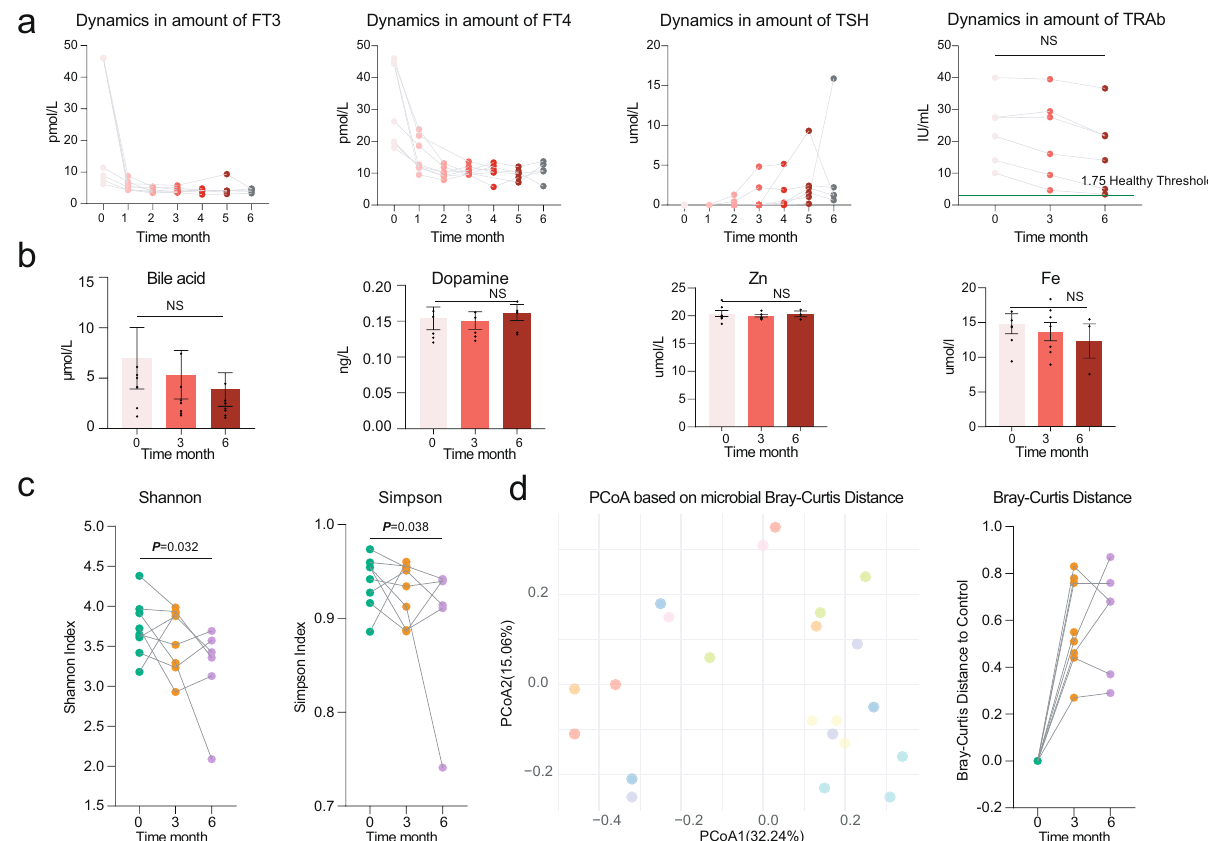
Fig. 2 The methimazole intake improved the thyroid function of GD patients. a Dynamic in the concentration of thyroid indexes including free triiodothyronine (FT3), free thyroxine (FT4), thyroid-stimulating hormone (TSH), and thyroid-stimulating hormone receptor antibodies (TRAb) during the whole experiment, these indexes were determined monthly. b Dynamic in the concentration of bloody bile acid, Dopamine, Zn, and Fe, these indexes were determined at baseline, month 3 and month 6. c The impacts of methimazole on intestinal microbial alpha diversity, the points in the same color represented the different subjects in the same time points. d Principal coordinates analysis (PCoA) based on Bray-Curtis distances of metagenomic species, the points in the same color represented the same subjects in the different time